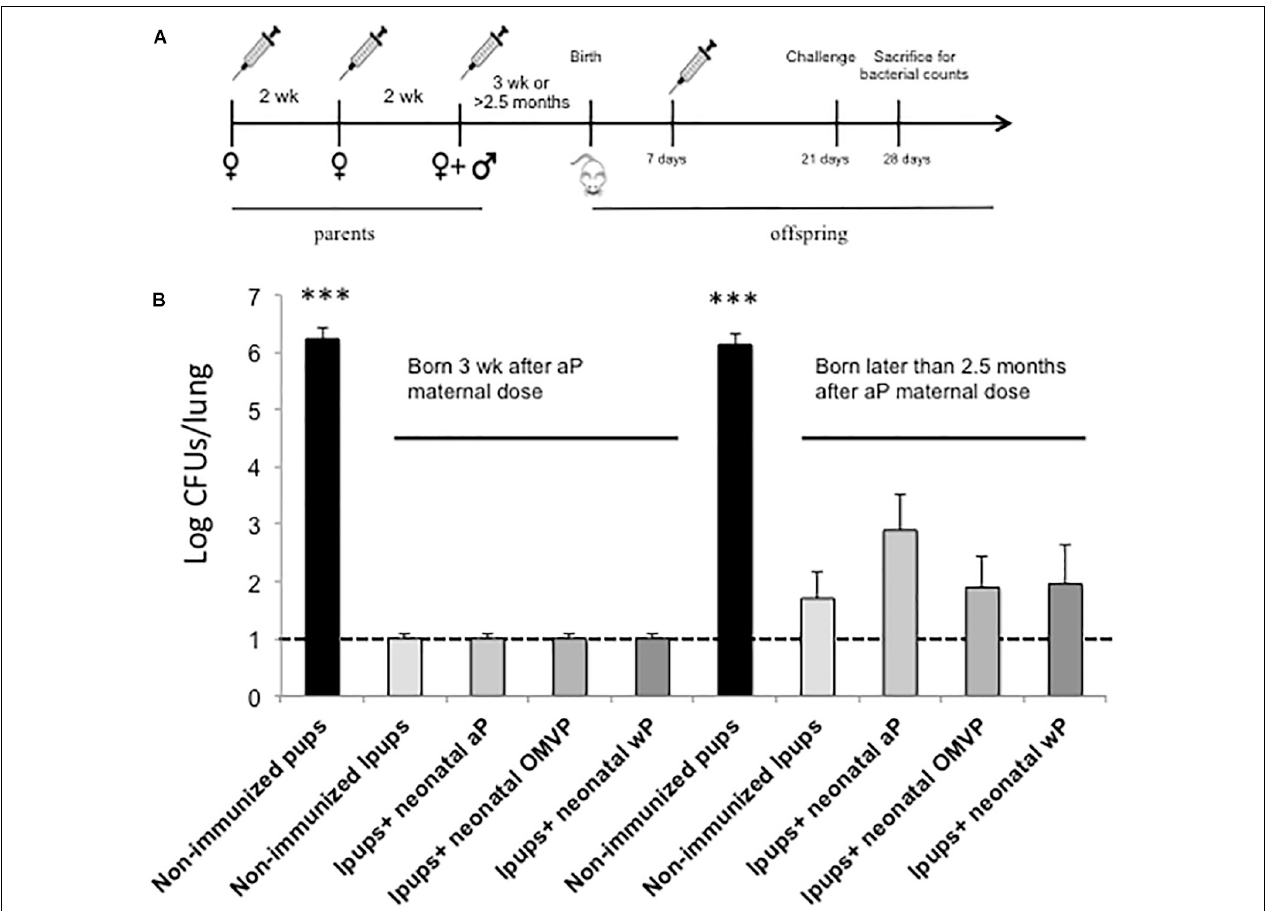
FIGURE 5 | Effect of neonatal immunization on the protection of pups with maternal immunity against B. pertussis infection. (A) Schematic representation of the vaccination and challenge protocols. Seven-day-old neonatal mice born either 3 weeks or later than 2.5 months after maternal aP immunization were vaccinated with a commercial aP or wP or the OMV P vaccine ( n = 6 in each group). Non-immunized mice were used as a negative control for protection. All the groups were challenged with B. pertussis at 28 days after birth. (B) Protection of offspring through the vaccination schedules of (A) . The number of bacteria recovered from the mouse lungs, expressed as the log 10 of the CFUs per lung, is plotted on the ordinate for the treatments indicated on the abscissa , with the data representing the means ± the SD. The dotted horizontal line indicates the lower limit of detection. The left side of the panel depicts the CFU values for the different groups of mice born 3 weeks after the last maternal vaccination, while the right side contains the corresponding data for the same experimental groups born 2.5 months after that last maternal vaccination. ∗∗∗ p < 0.001 non-immunized mice versus immunized Ipups. A significant difference ( p < 0.05) was also recorded between the CFU values detected in the aP-vaccinated Ipups born 2.5 months after maternal immunization and those values detected in the non-vaccinated and vaccinated Ipups born 3 weeks after the completion of maternal